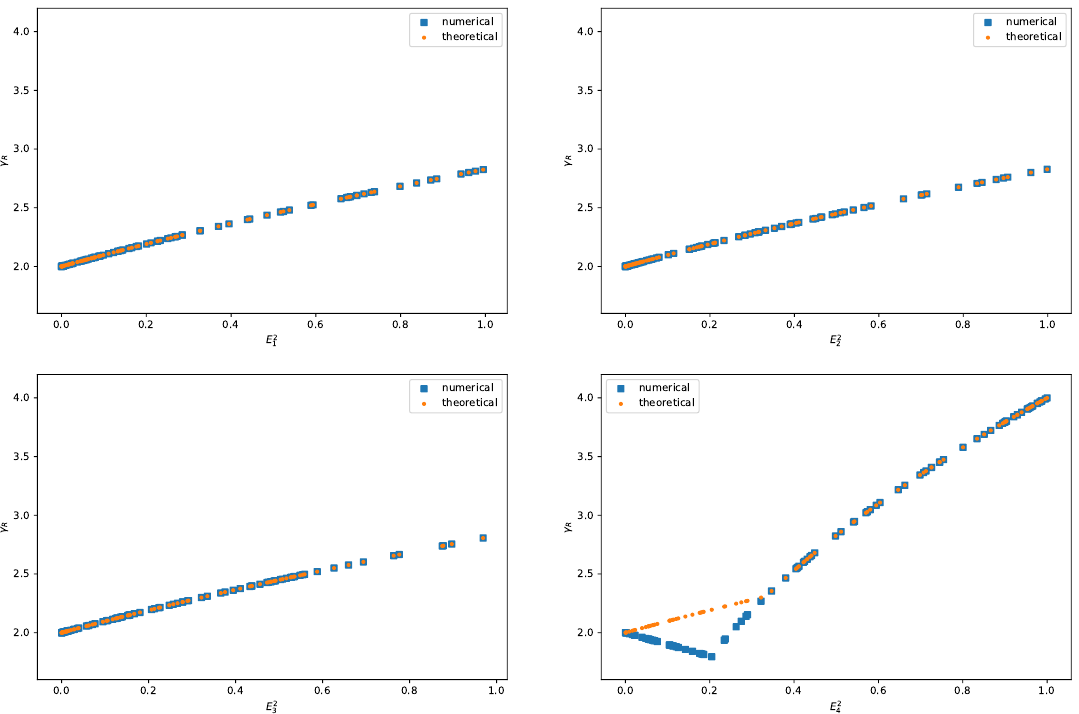
Figure 4 . Theoretical (orange) and numerical results (blue) versus E 2 right), E 2 (lower left), and E 2 3